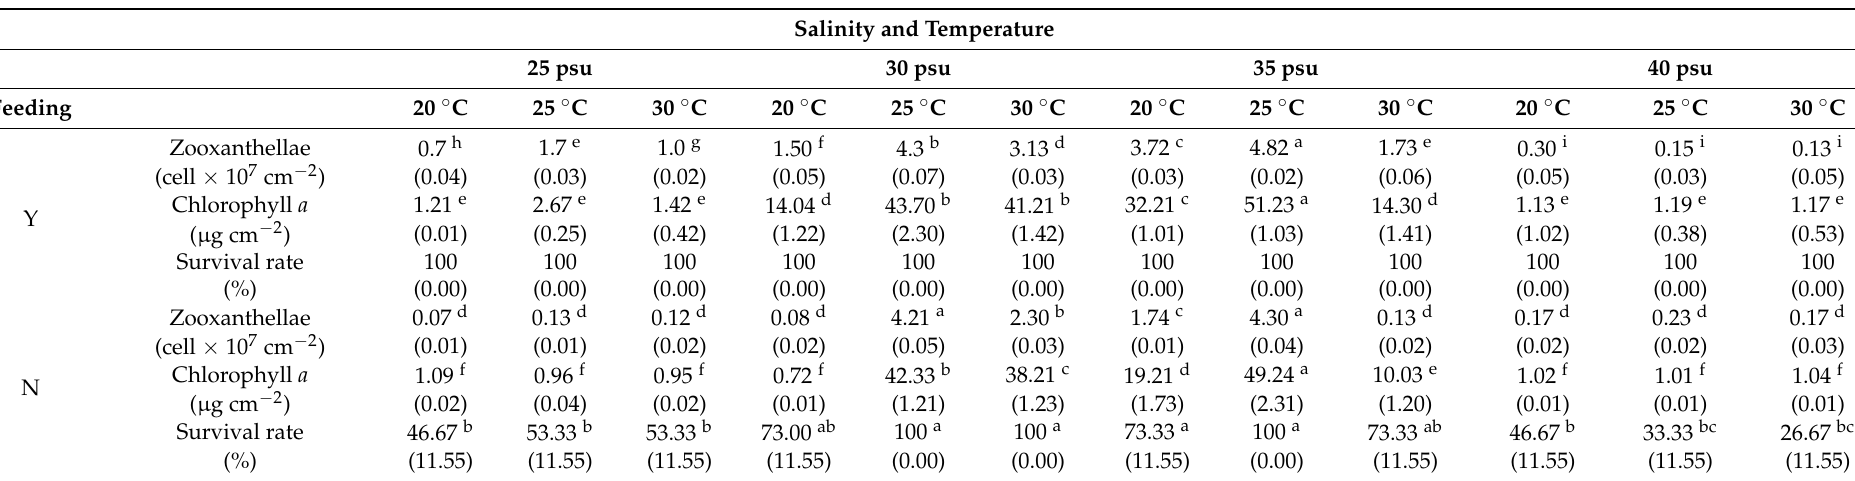
Table 4. The effect of feeding on Briareum violacea zooxanthellae, chlorophyll a and survival during temperature and salinity